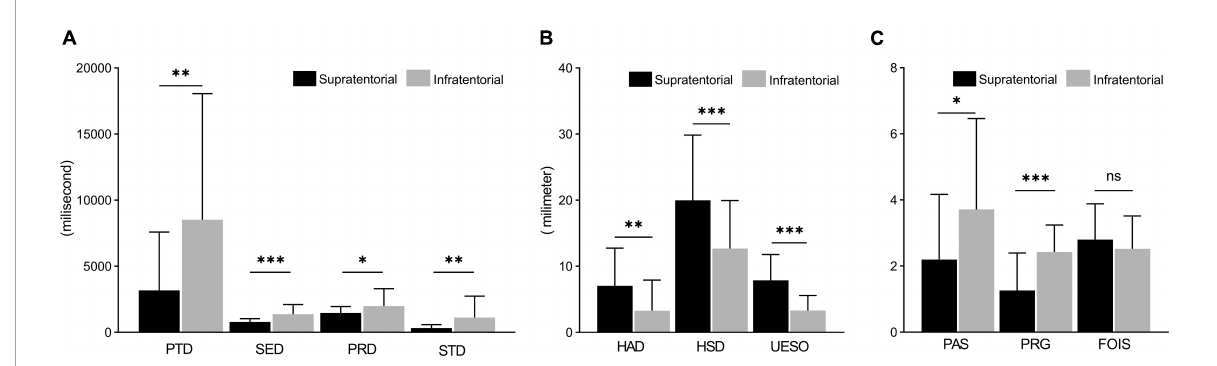
FIGURE3 The comparison of measures between supratentorial and infratentorial stroke group. (A) Measures of duration (including PTD, SED, PRD, and STD) under a VFSS examination. (B) Measures of motion (include HAD, HSD, and UESO) under a VFSS examination. (C) Measures of pharyngeal function (including PAS, PRG, and FOIS) under a VFSS examination. PAS, Penetration-Aspiration Scale; FOIS, Functional Oral Intake Scale; PRG, Pharyngeal Residual Grade; PTD, pharyngeal transit duration; HAD, hyoid bone anterior-horizontal displacement; HSD, hyoid bone superior-horizontal displacement; SET, soft palate elevation duration; PRD, pharyngeal response duration; STD, stage transition duration; UESO, upper esophageal sphincter opening. ∗ p < 0.05; ∗∗ p < 0.01; ∗∗∗ p < 0.001.